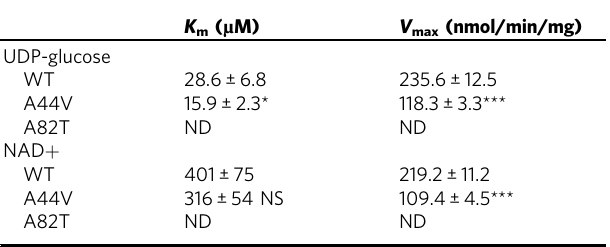
Table 2 Summary of WT and mutant UGDH kinetic